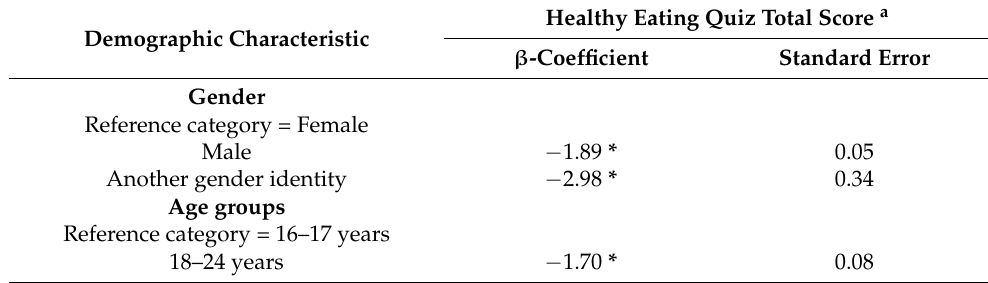
Table 3. Linear regression of Healthy Eating Quiz total scores by demographic characteristics ( n =